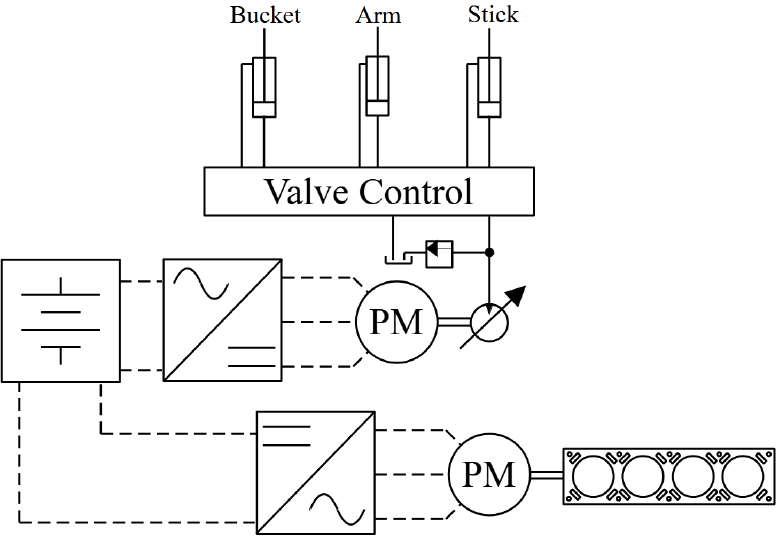
Figure 3. Series configuration applied to the implements of a backhoe.